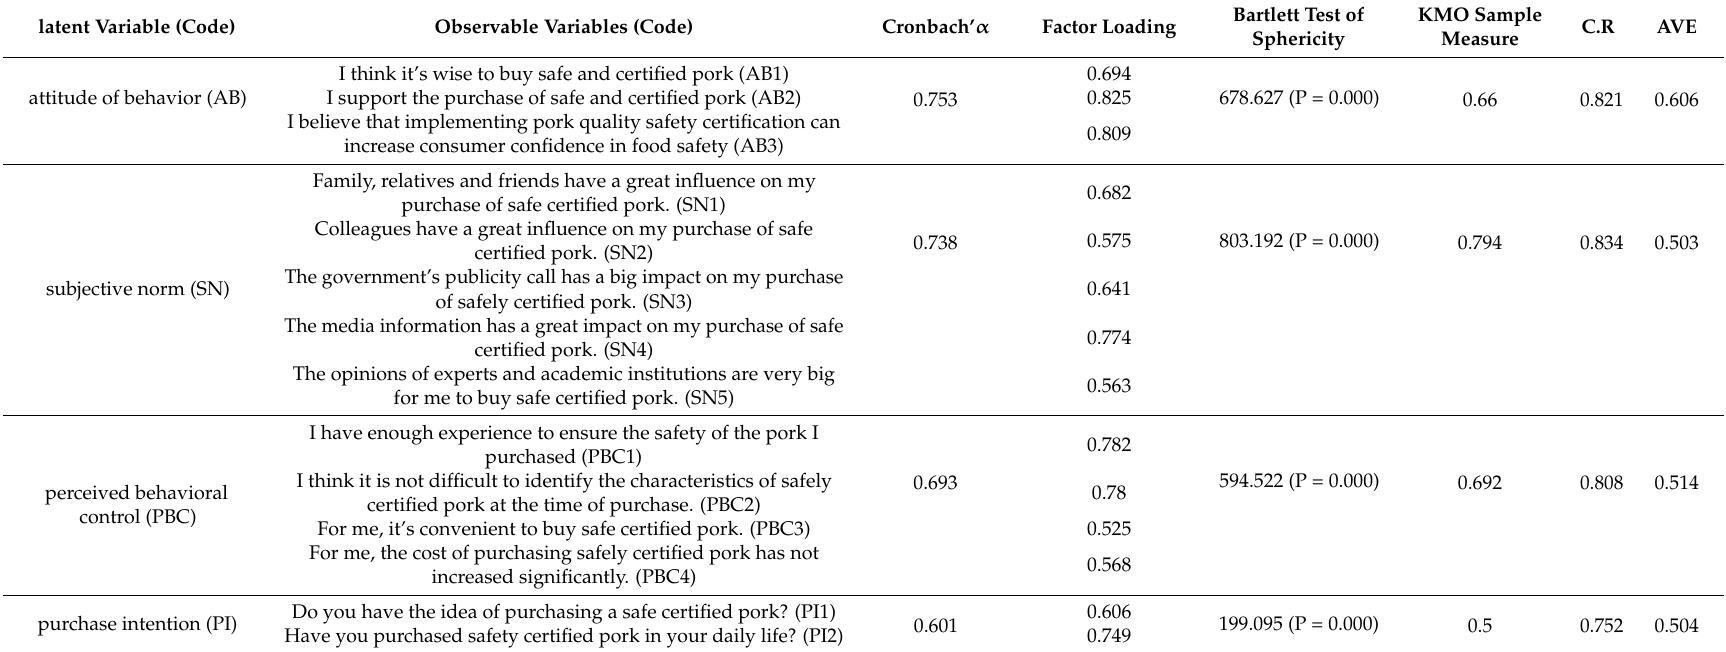
Table 3. Test of